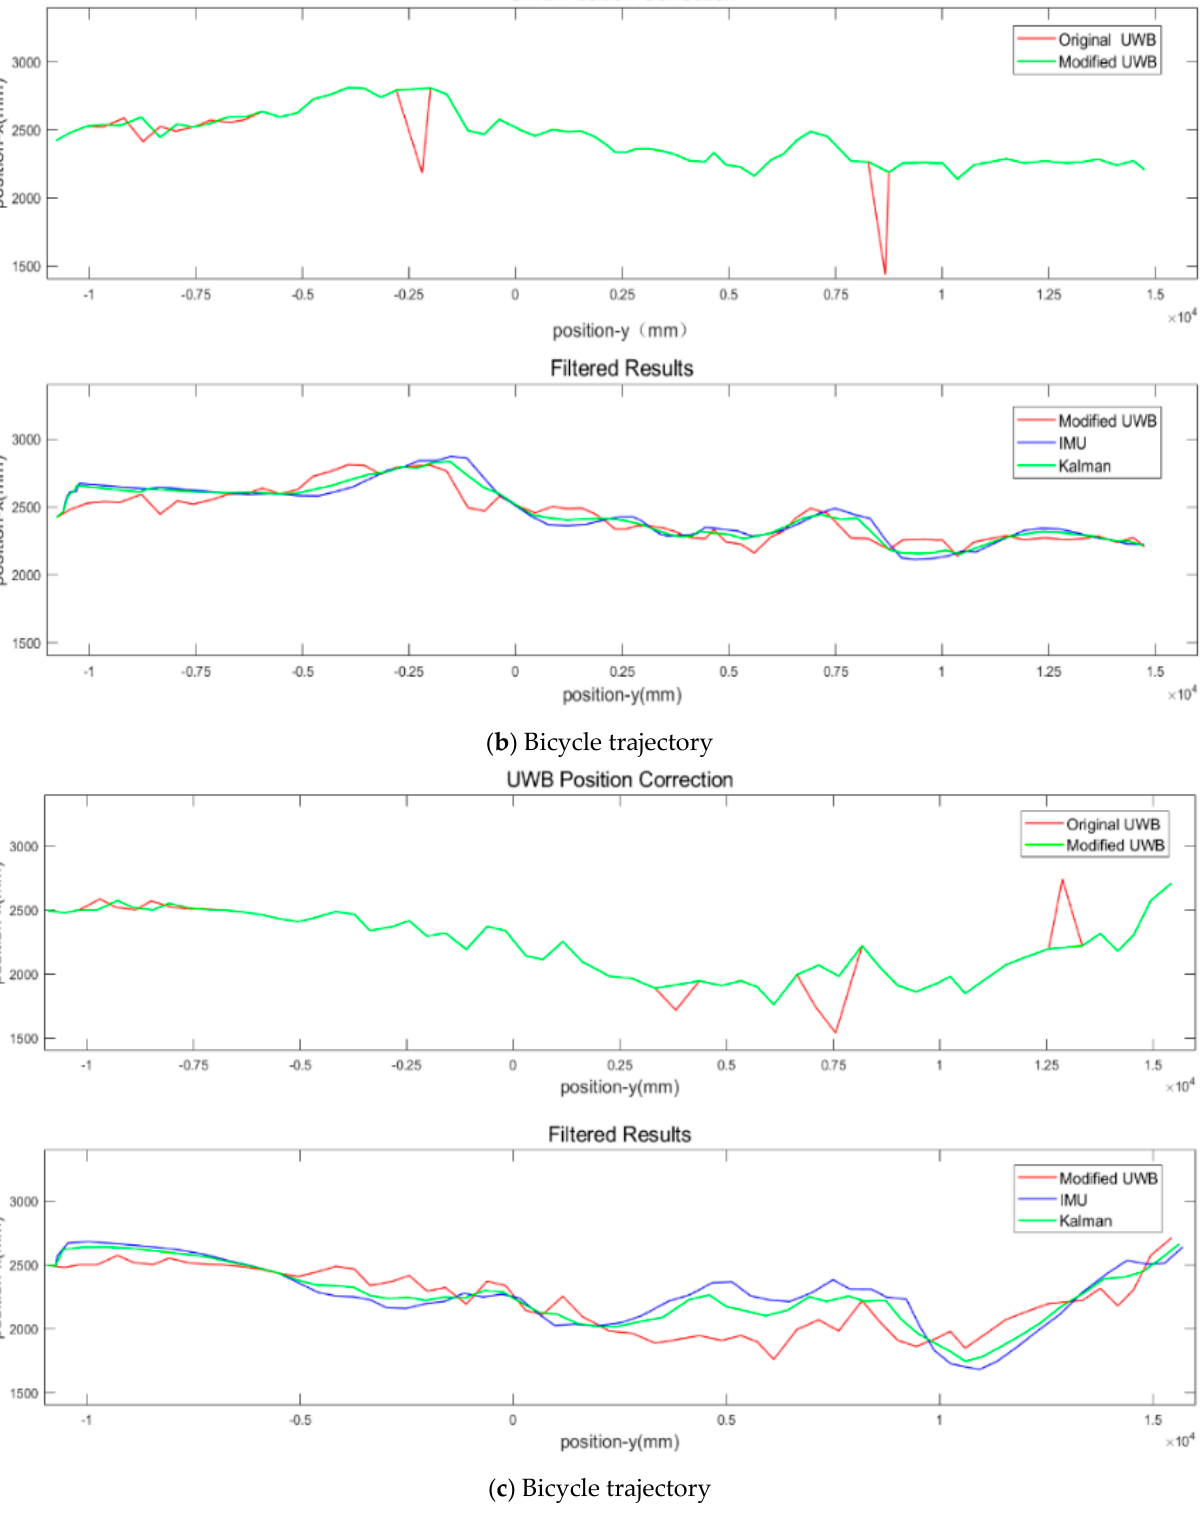
Figure 4. Filtered bicycle trajectories. The algorithm codes are available upon request.